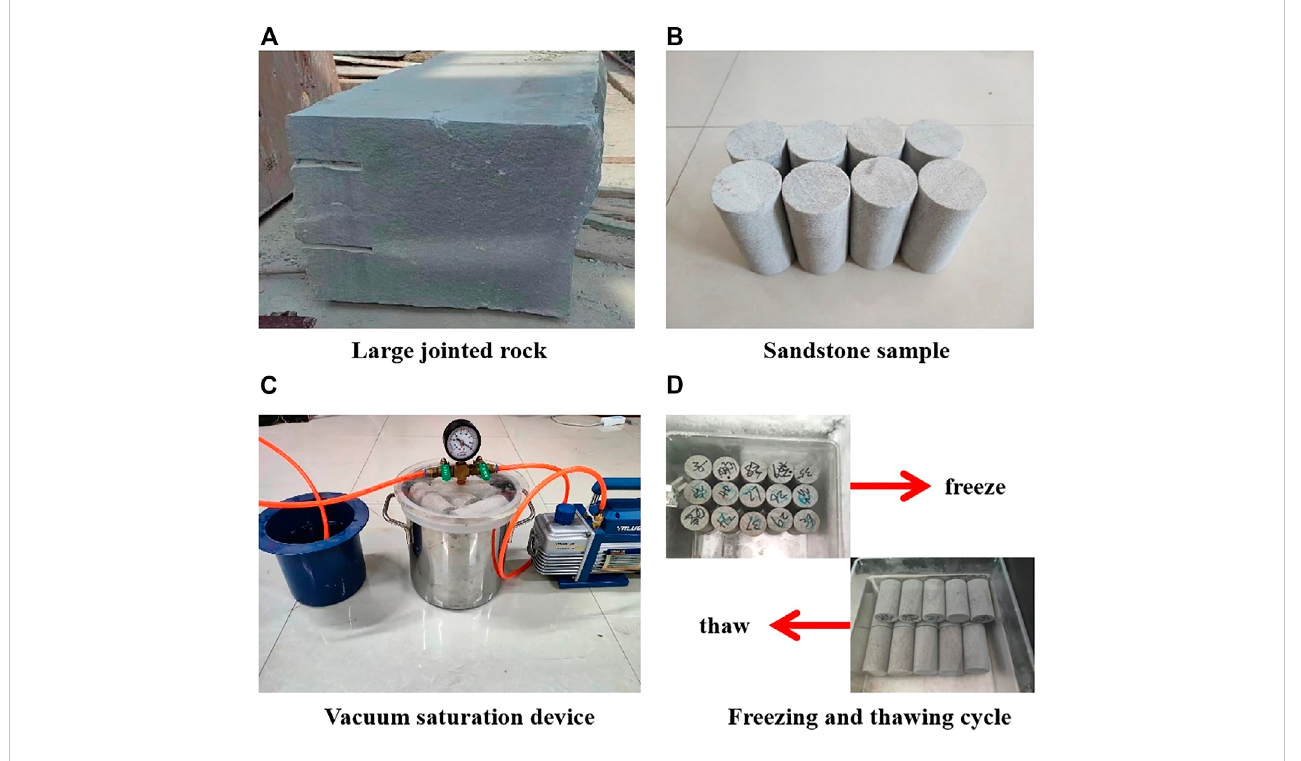
FIGURE 1 Preparation of freeze-thaw sandstone